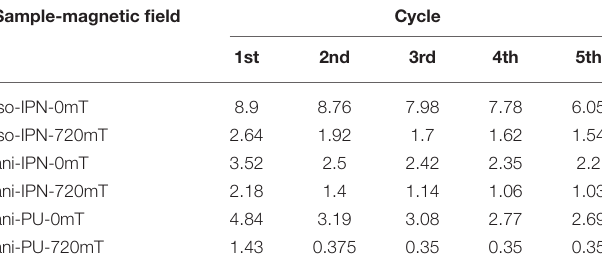
TABLE 4 | Fitting parameter γ c (%) of the samples in the different cycles. Sample-magnetic field